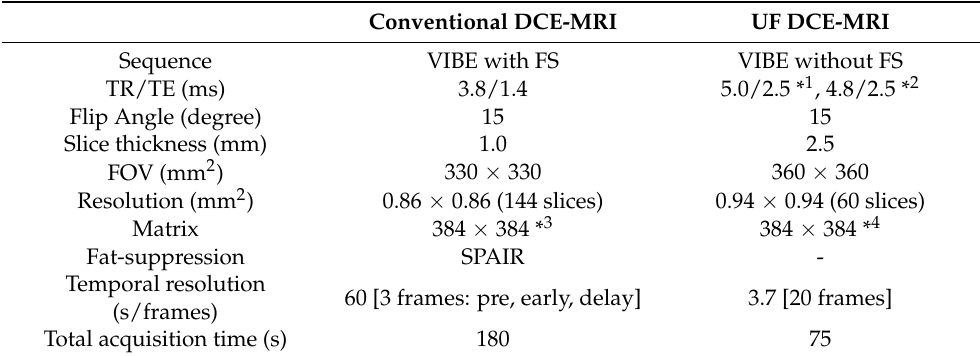
Table 1. A schematic drawing of the order of our dynamic protocols including UF DCE-MRI is shown in Figure 2. Table 1. Scan protocols of the conventional DCE-MRI and UF DCE-MRI.